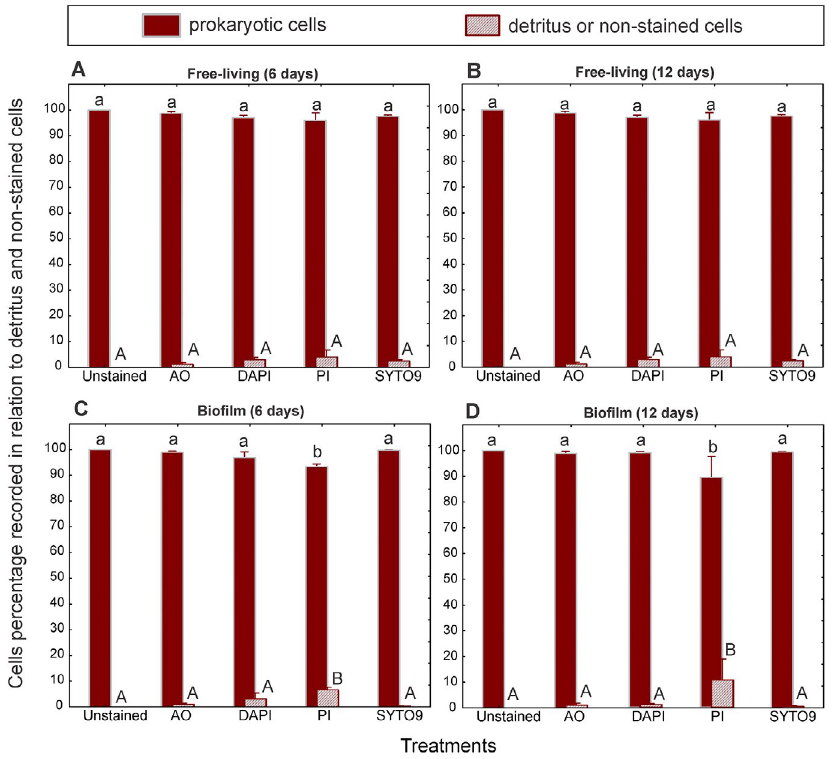
Fig. S2. – One-way ANOVA results showing differences in prokaryotes cells recorded by the flow cytometer with stains compared with detritus/non-stained particles at 6 and 12 days of exposure. A, free-living prokaryotes at 6 days; B, free-living prokaryotes at 12 days;